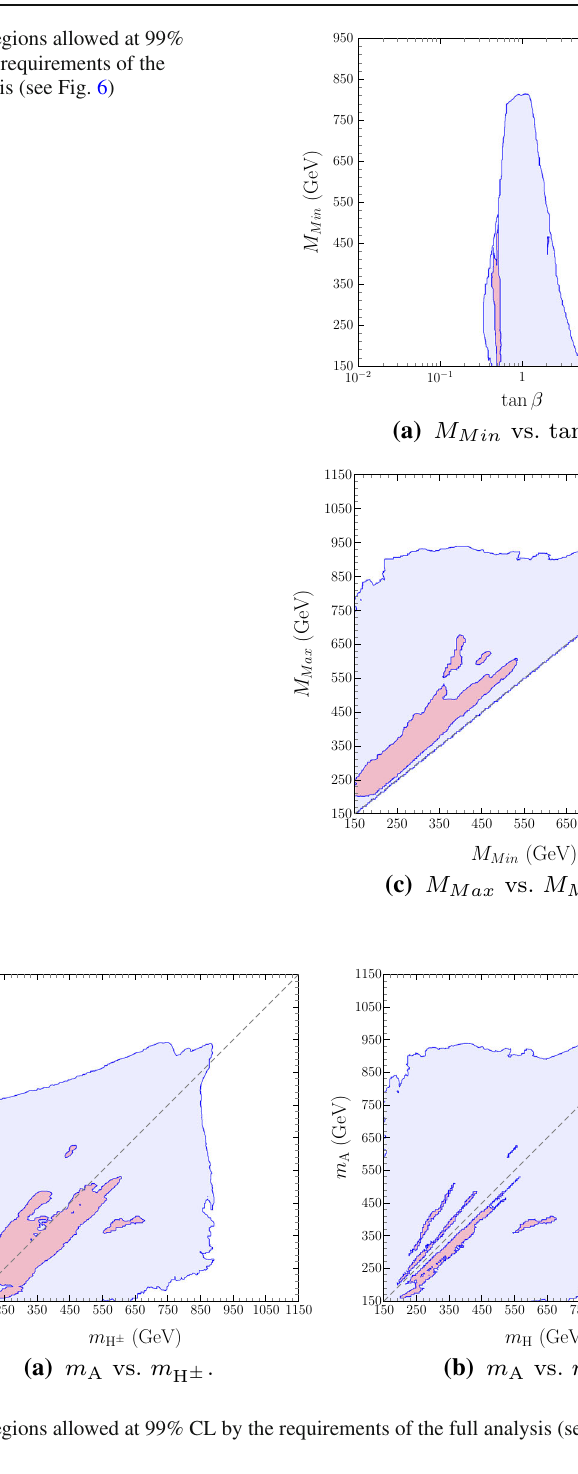
Fig. 7 Regions allowed at 99% CL by the requirements of the full analysis (see Fig. 6)